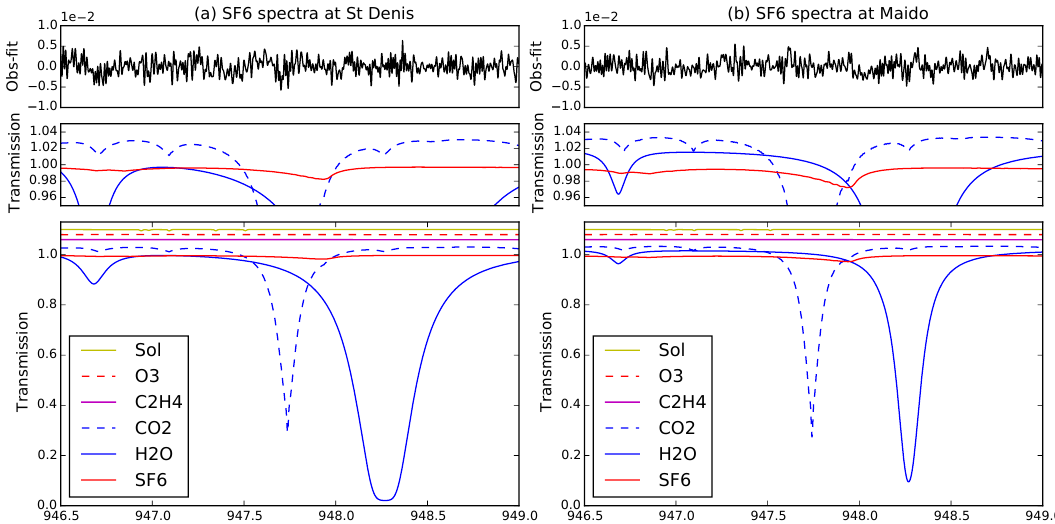
Figure 2. The typical spectrum of SF 6 retrieval microwindows (946.5–949.0cm − 1 ) at St Denis (a) and Maïdo (b) . The bottom panels list the absorption contribution from each species. To clarify the absorption lines, the transmittance is shifted by 0.02 for each species and the solar (sol) line list. The middle panels only show the transmittance between 0.95 and 1.05 and identify the SF 6 absorption line. The top panels show the transmittance residual (observed minus